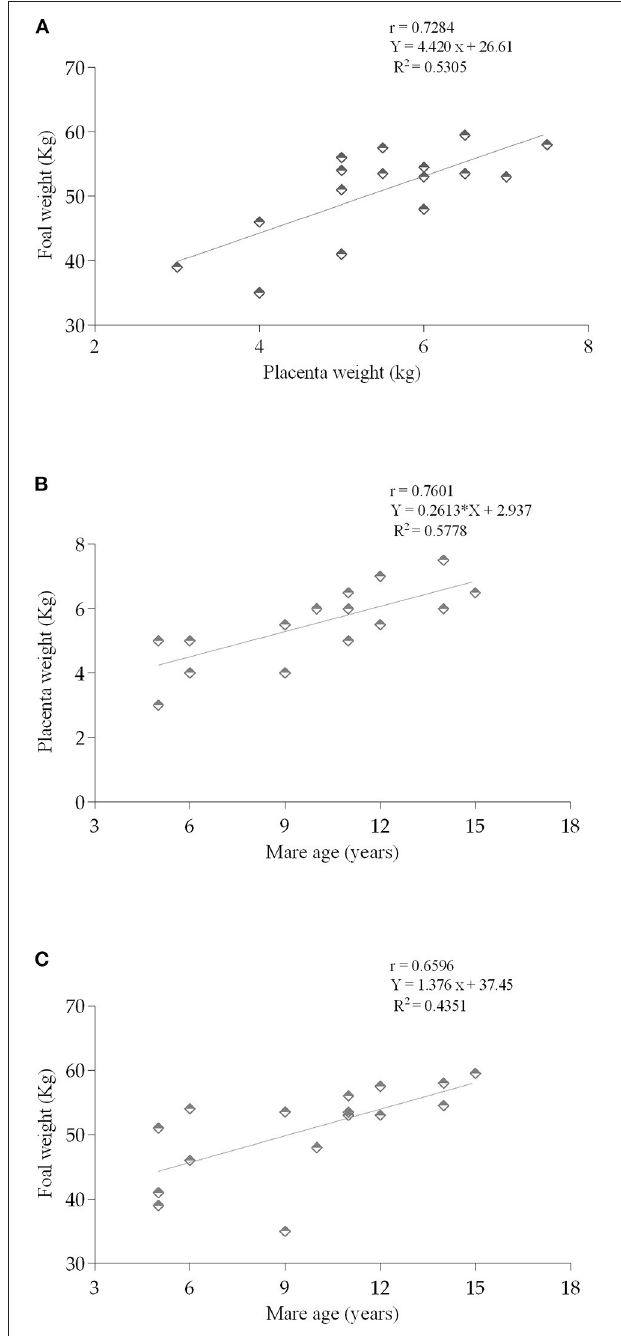
FIGURE 2 | Relationship between the (A) weight of the placenta (kg) and foal weight at 24h (kg) ( p = 0.0014); (B) mares age (years) and placenta weight ( p = 0.0006); and (C) mares age and the weight of the foal (kg) ( p = 0.0054). Pearson correlation (r). Linear regression (R 2